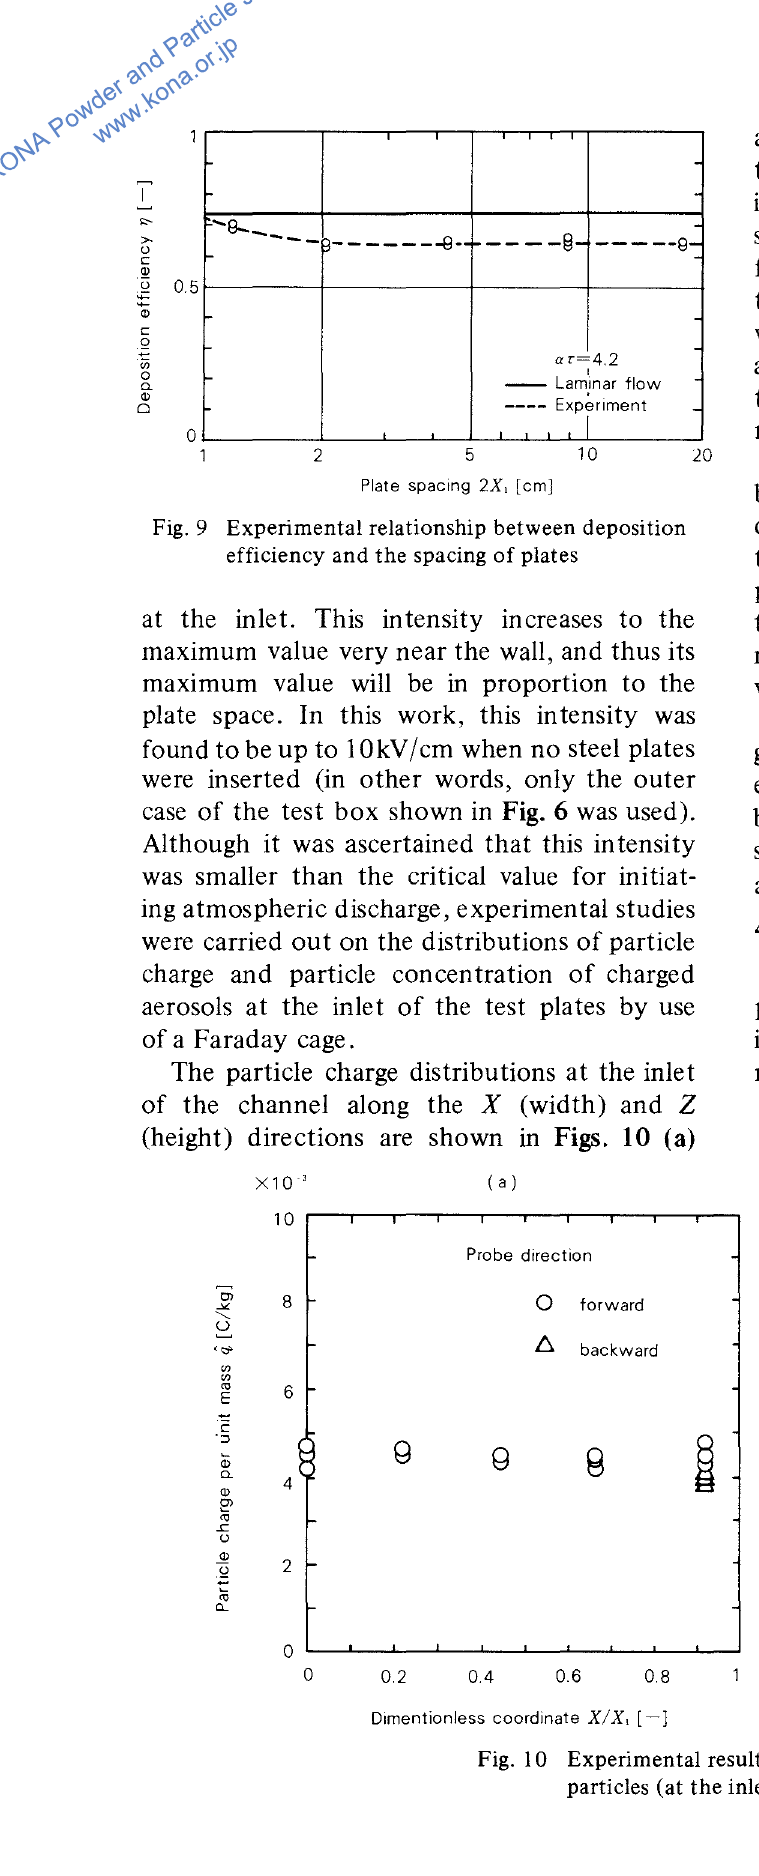
Fig. 1 0 Experimental results on the specific charge of particles (at the inlet of test